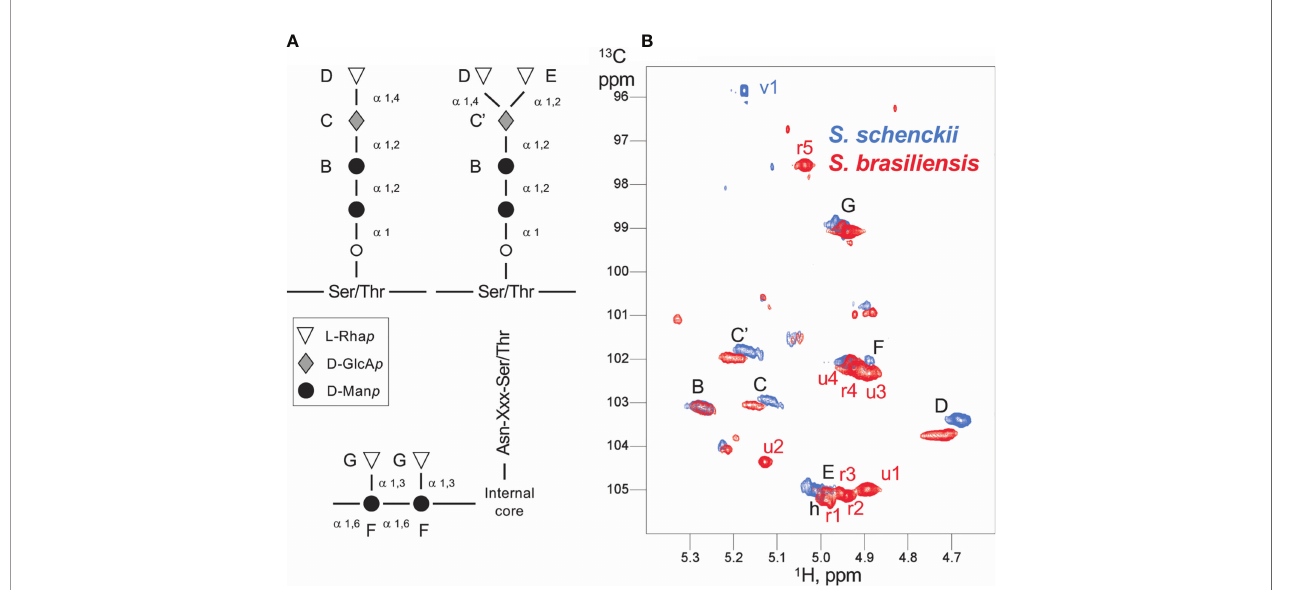
FIGURE 8 | Scheme of the Sporothrix peptidorhamnomannan (PRM) organization and NMR assignments. (A) The generally known structures of the O-linked (top) and N-linked rhamnomannan (bottom) are shown. The inter-residue linkage types are displayed. The capital letters from B to G denote the assignments obtained by NMR, and the corresponding signals are displayed in panel (B). (B) Anomeric region of the 1 H- 13 C HSQC spectra of Sporothrix schenckii (blue) and Sporothrix brasiliensis (red) crude PRMs. Each signal arises from the anomeric 1 H- 13 C group of a distinct polysaccharide unit. The signals common to both species (and thus common residues) are labeled in black, whereas the signals unique to a species are labeled in the corresponding color. Capital letters denote signals from assigned residues; the corresponding residues are labeled in the PRM organization scheme (A) . The mannose O-linked to Ser/Thr could not be assigned. Whereas S. schenckii only shows a single residue absent (v1) in S. brasiliensis , the later displays at least nine unique residues with fi ve identi fi ed rhamnose units (r1 to r5) and four yet unidenti fi ed units (u1 –